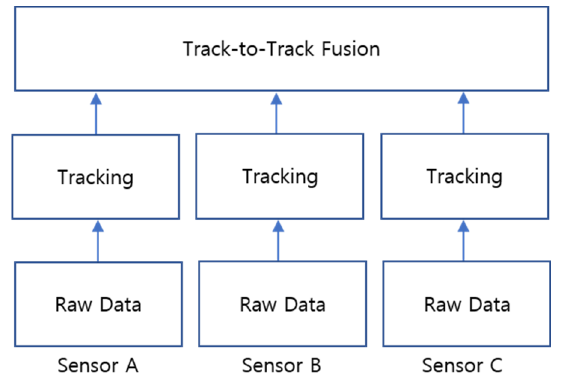
10 of 32 Figure 3. Operation of the unbiased converted measurement Kalman filter algorithm. 3.2. Data Fusion A track-to-track fusion approach is employed in this study for combining high-level data from multiple sources. The data processing for each sensor system is performed individually at the sensor level in a high-level fusion system. Each sensor system outputs one or more tracks based on the sensor measurements, and the state estimates from